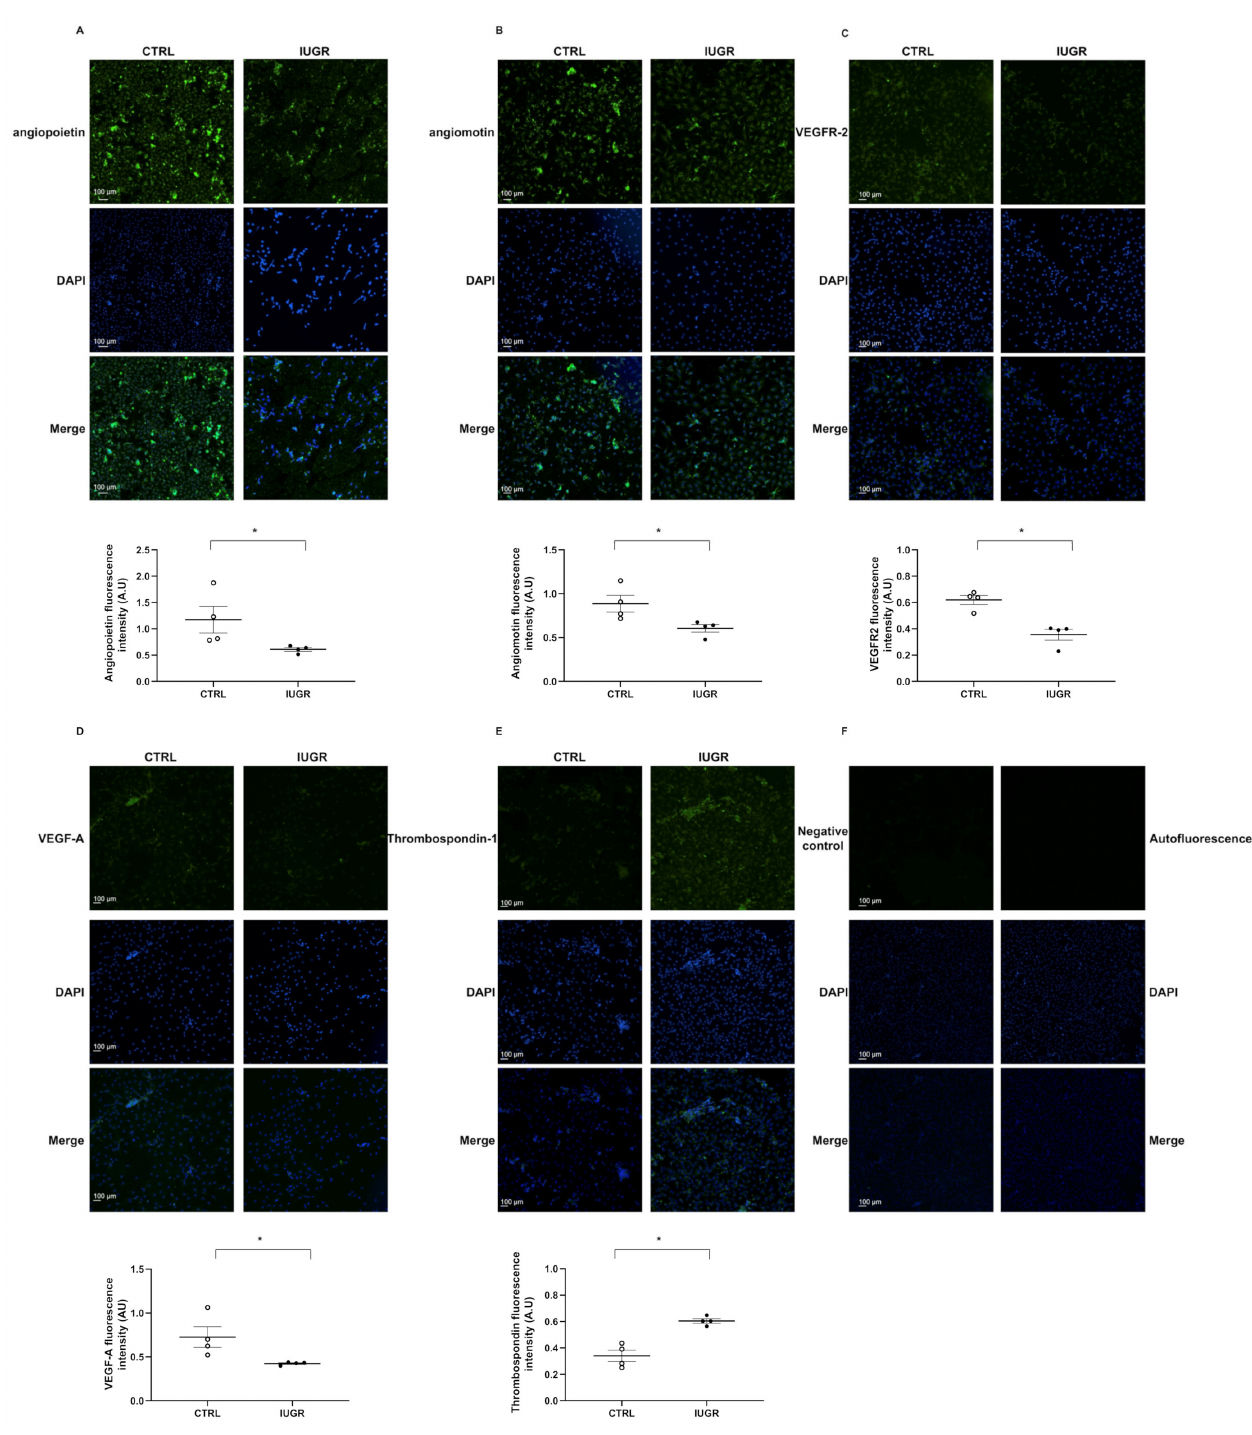
Figure 7. Angiogenic profile of ECFCs. Angiopoietin ( A ), angiomotin ( B ), VEGFR-2 ( C ), VEGF-A ( D ), and thrombospondin-1 ( E ) protein expression was measured by immunofluorescence in CTRL-ECFCs and IUGR-ECFCs isolated from six-month-old male rats. Magnification (20 × ). Nuclei were counterstained with DAPI. A negative control (with no primary antibody) and test of autofluorescence were performed ( F ). These pictures are representative images from n = 4 animals/group; * p < 0.05. Scale bar = 100 µ